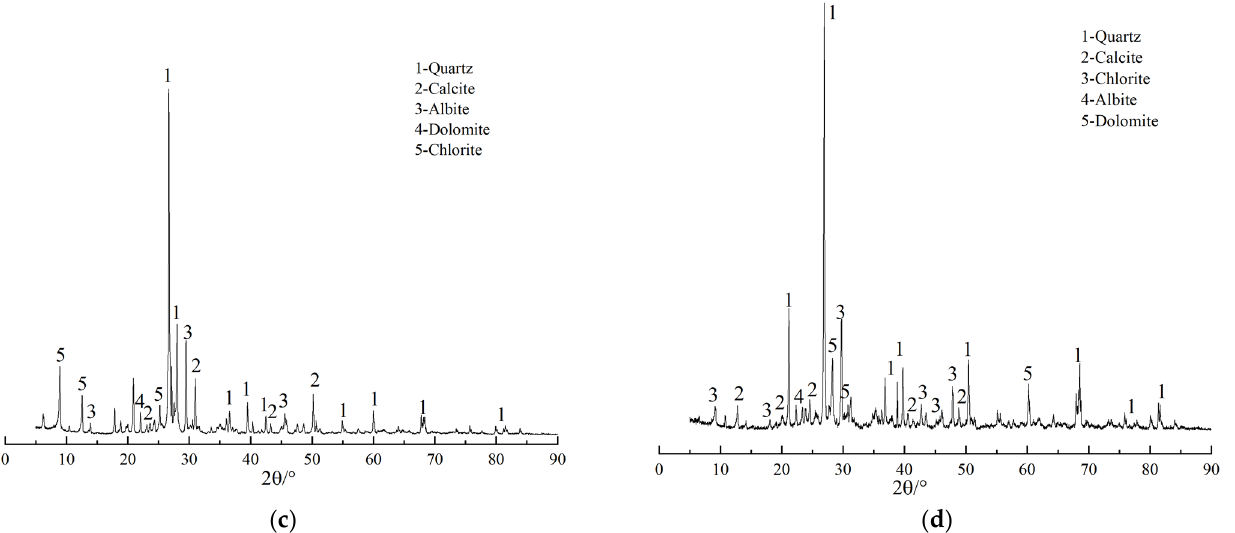
Figure 9. XRD patterns of loess under different freeze–thaw cycles. ( a ) The number of freeze–thaw cycles is 0. ( b ) The number of freeze–thaw cycles is 2. ( c ) The number of freeze–thaw cycles is 6. ( d ) The number of freeze–thaw cycles is 20.